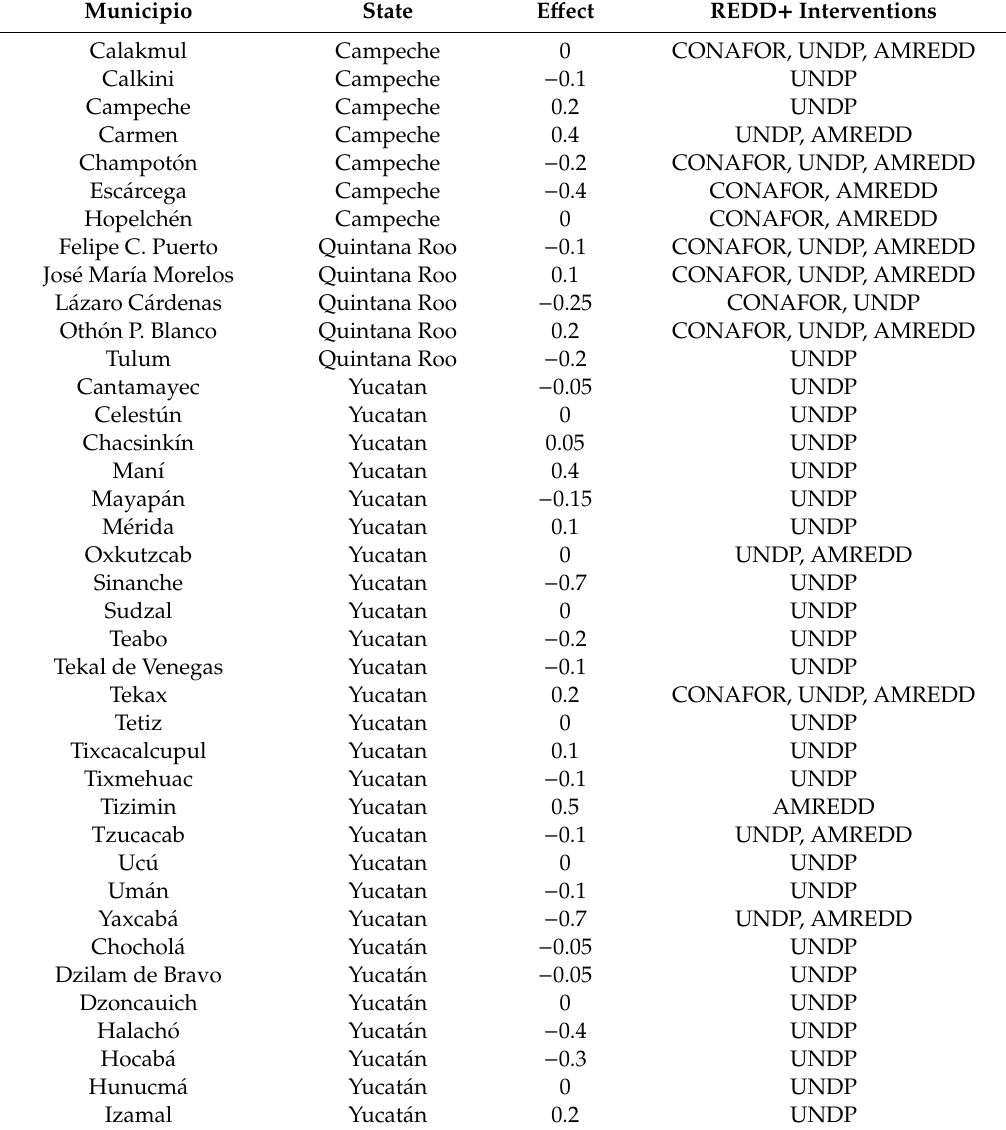
Table 3. Synthetic Control Method (SCM) results of treated unit e ff ects for each REDD + municipality (negative sign indicates reduction in deforestation rate) (CONAFOR = National Forestry Commission, UNDP = United Nations Development Program, AMREDD = Mexico REDD +